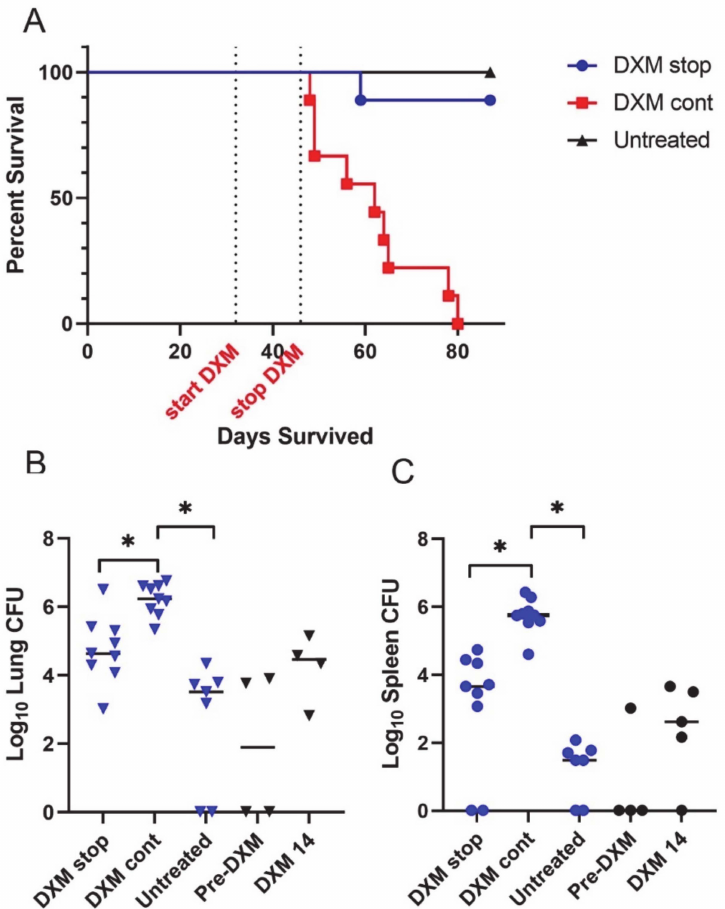
Figure 3. Survival and fungal burdens of 2-week or continuous treatment with DXM. ( A ) Mice (n = 10/group) treated continuously with DXM (DXM cont) became moribund before scheduled sacrifice (day 87 post-infection). ( B ) Right lung fungal burdens of mice treated with DXM for 14 days and then discontinued (DXM stop) were intermediate compared with mice treated continuously (DXM cont) and untreated mice. DXM cont fungal burdens were significantly higher than the untreated ( p < 0.0001) and DXM stop mice ( p = 0.0447). The right lung fungal burdens of mice before the start of DXM (pre-DXM) and on the 14th day of treatment (DXM 14) show that the fungal burden increased rapidly with immunosuppression and remained approximately the same 6 weeks after discontinuation of DXM. ( C ) Spleen fungal burdens paralleled lung data (DXM stop vs. DXM cont, p = 0.0105; untreated vs. DXM cont, p = 0.0001). (* Indicates statistical significance. Statistical